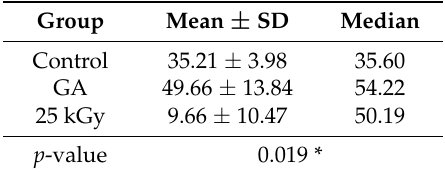
Table 2. Bone-to-implant contact within regions of interest (BIC,